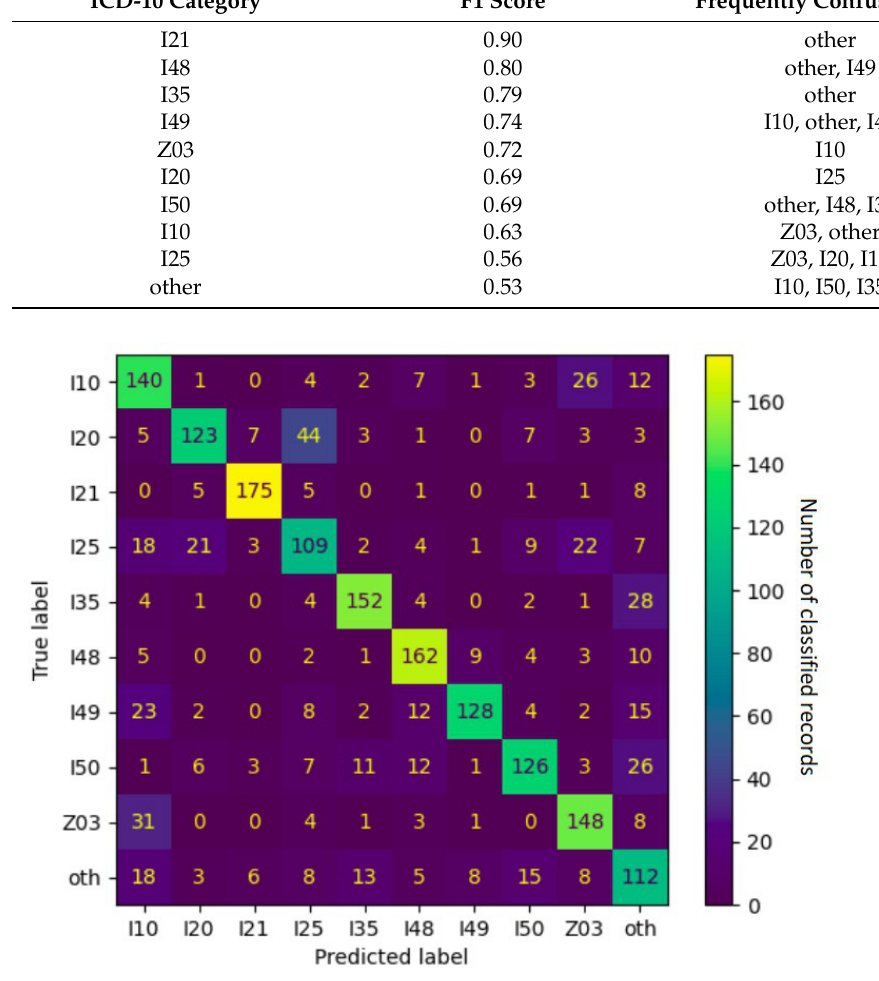
Figure 8. Confusion matrix of a 9 + 1 setup fine-tuned on both admission and discharge data. Numbers refer to counts of examples in the respective categories, and the color spectrum reflects the contrast in their proportions.